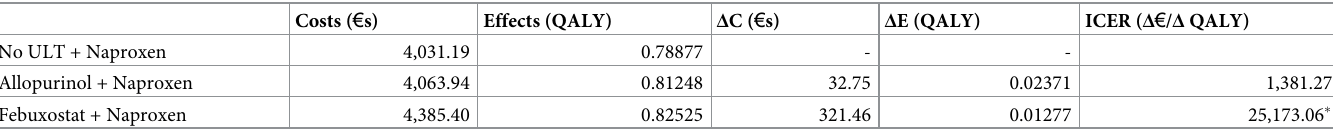
Table 2. Probabilistic sensitivity analysis for urate lowering therapy combined with naproxen.